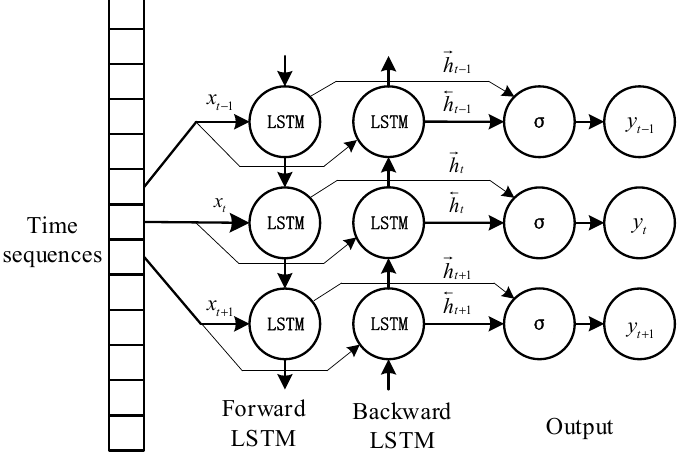
Figure 3. Structure of BiLSTM.